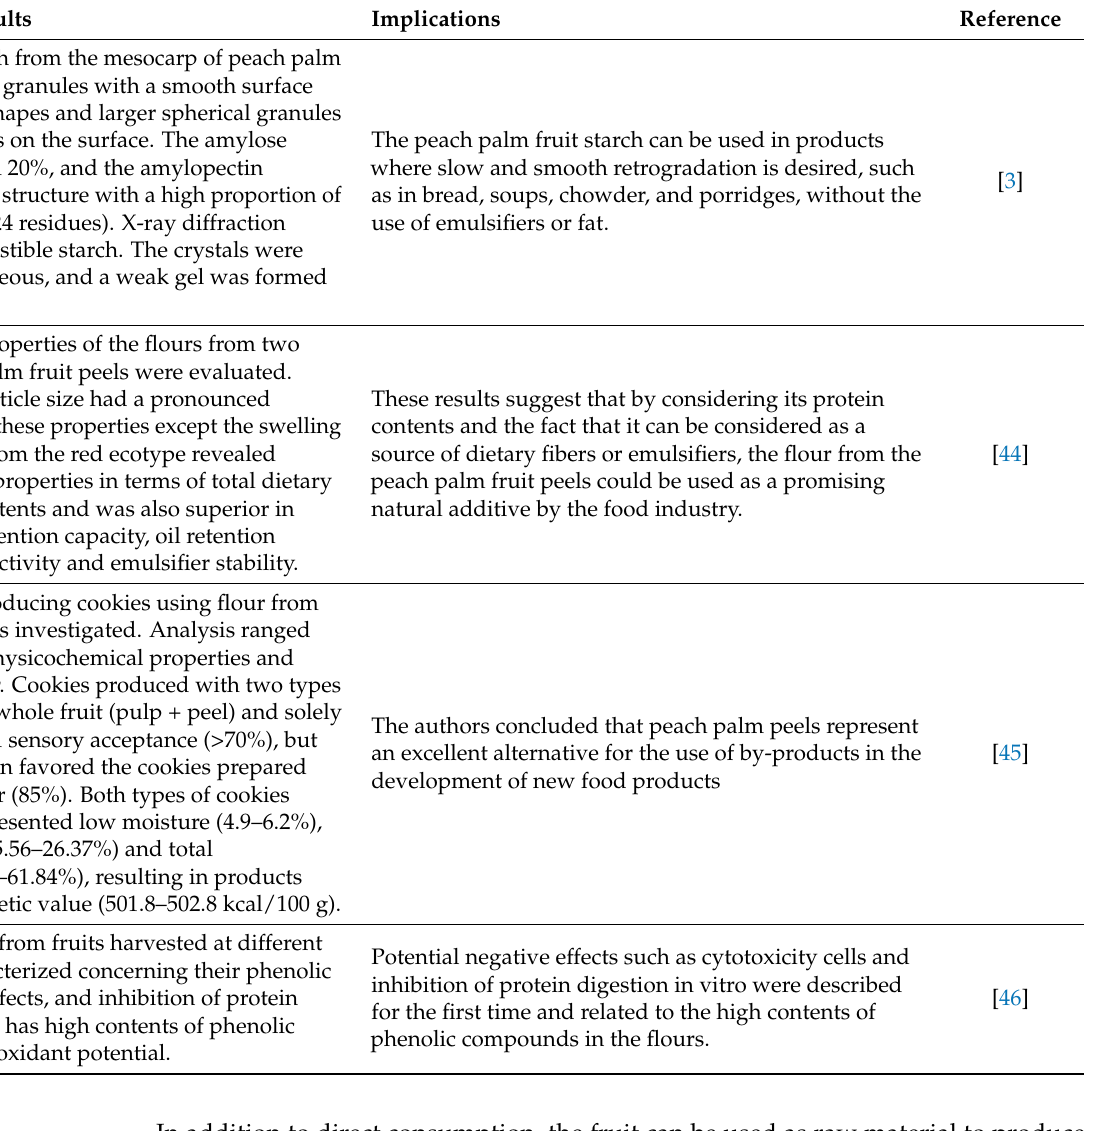
Table 2. Recently published articles on starch and flour from peach palm